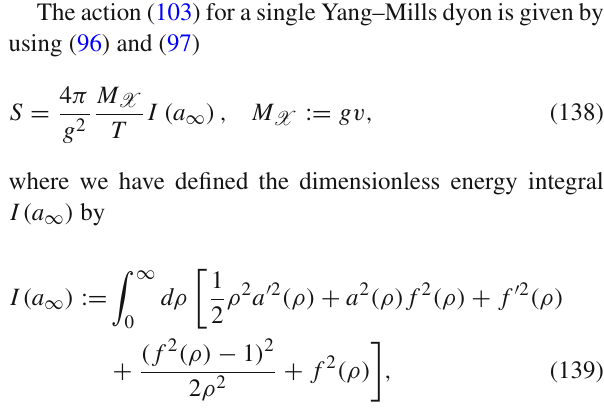
The action (103) for a single Yang–Mills dyon is given by using (96) and (97)